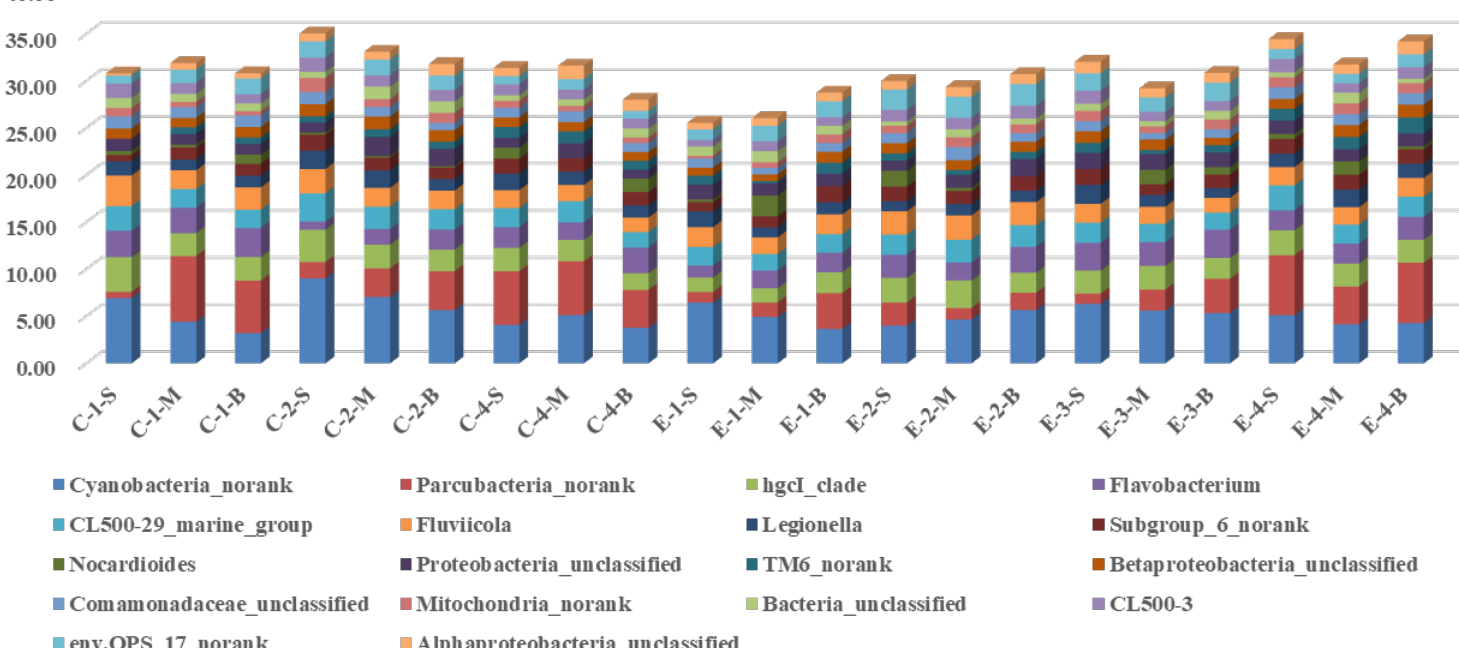
Figure 7. Distribution of the main genera during the operation of the water-lifting aeration system (>1%). Labeling is consistent with that of Figure 4.